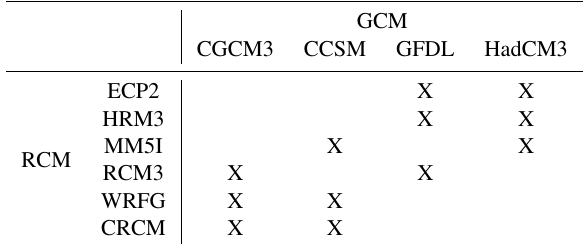
Table 2. The various GCM–RCM combinations considered in the NARCCAP are indicated by “X”. This table is ordered so as to high- light the two 2 × 2 mini-experiments (lower left and upper